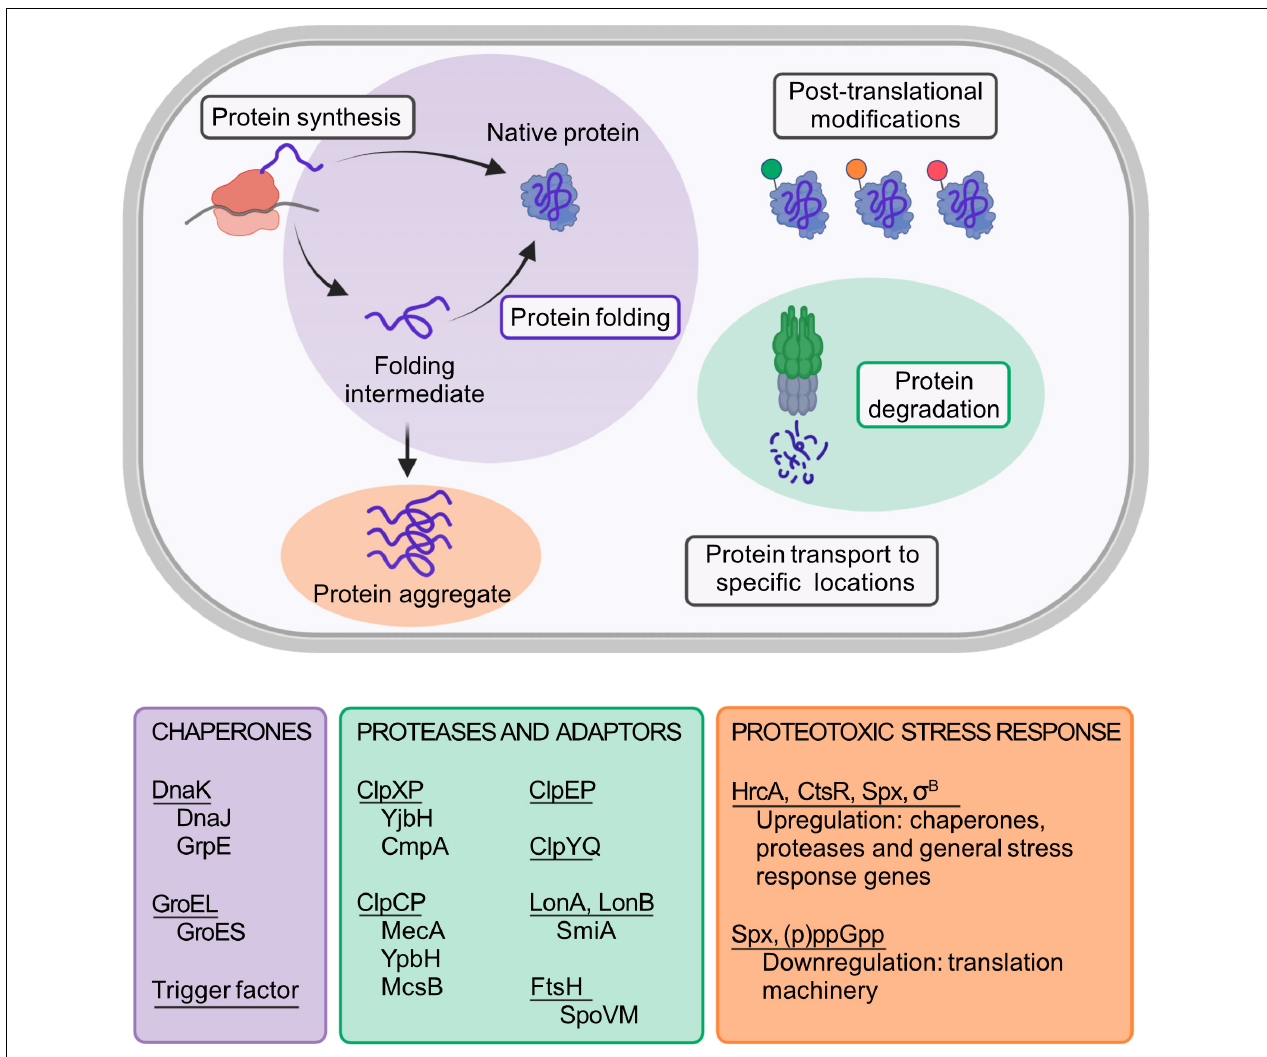
FIGURE 1 | Schematic representation of the B. subtilis proteostasis network and its regulators. Protein folding and degradation are two key cellular processes involved in proteostasis maintenance. While some proteins can spontaneously fold into their functional native state, many others need the assistance of molecular chaperones to do so. Underlined in the purple box are the main B. subtilis chaperones. For its full activity, DnaK requires the co-chaperone DnaJ and the nucleotide exchange factor GrpE. Similarly, GroEL requires the co-chaperonin GroES. Unneeded, misfolded or damaged proteins are eliminated from the cell by proteases (underlined in the green box) and its respective adaptor proteins (shown below each protease complex). In addition to protein folding and degradation, other key processes that affect proteostasis maintenance are protein synthesis, post-translational modifications, and the transport of proteins to specific locations. Failure in proteostasis maintenance often leads to the formation and accumulation of misfolded and aggregated proteins, a condition termed as proteotoxic stress. The main regulators that are known to be involved in the B. subtilis proteotoxic stress response are shown in the orange text box. Created with